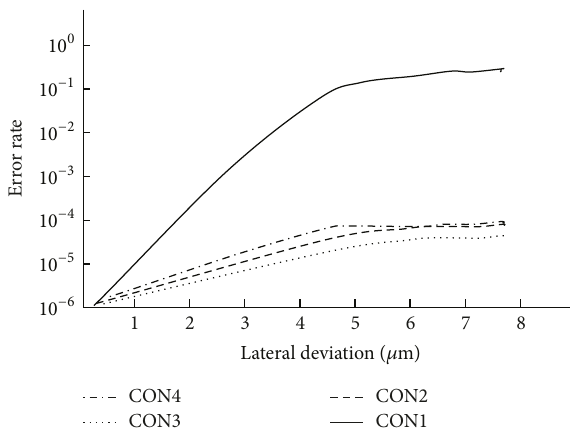
Figure 9: The relationship between error rate and lateral deviation (wavelength